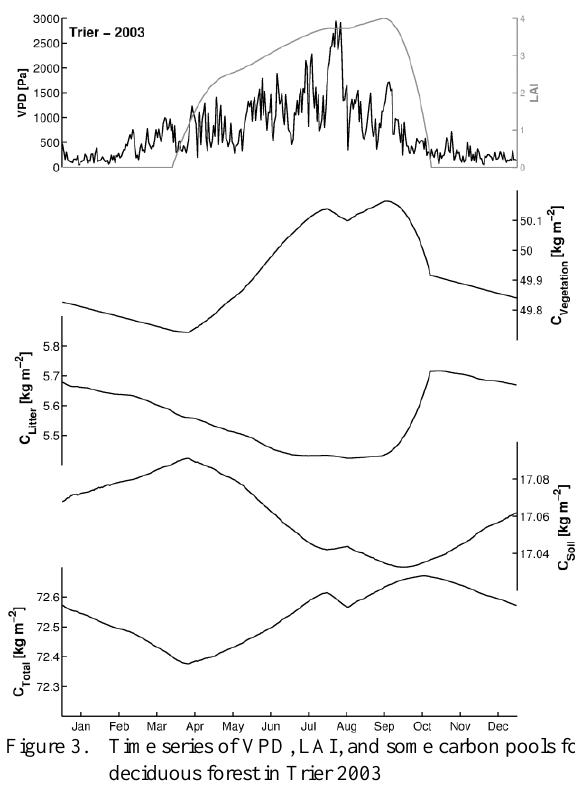
Figure 3. Time series of VPD, LAI, and some carbon pools for deciduous forest in Trier